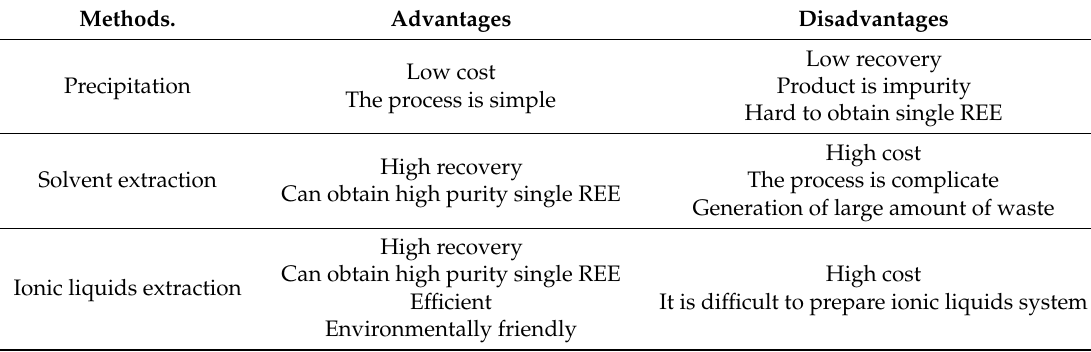
Table 3. Comparison of di ff erent REEs separation technologies for NdFeB permanent magnet scraps.